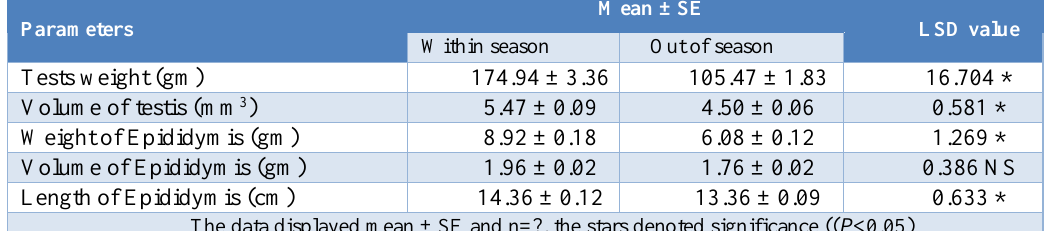
Table,1: Compare between with and without season in parameters study. Parameters